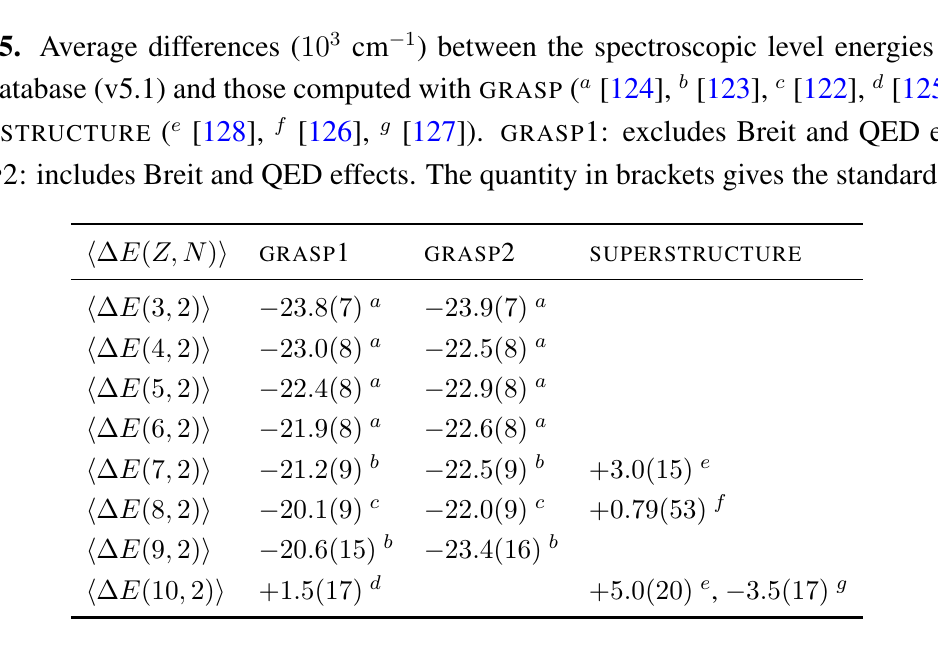
, 1 1 S ) (s − 1 ) electric quadrupole (E2) rate 2 0